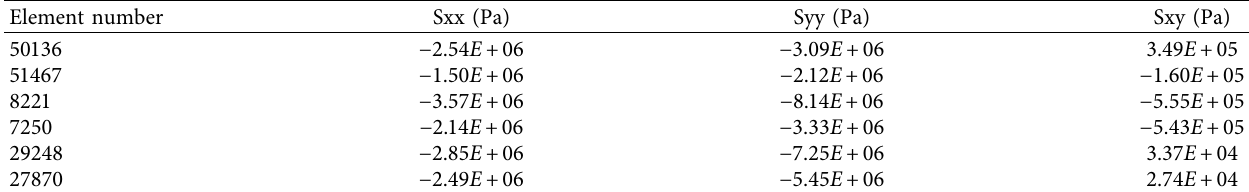
Table 4: “The measured data” of the in situ stress.